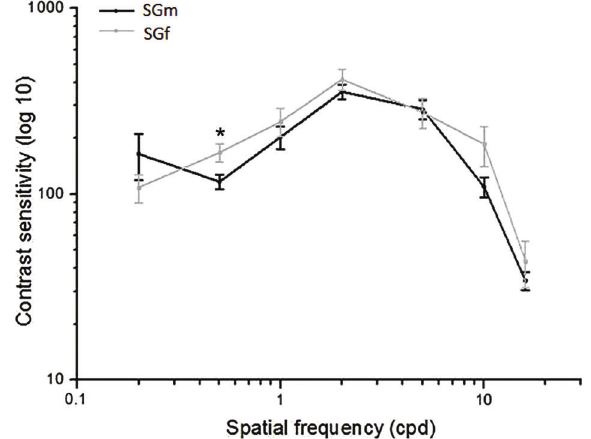
Figure 3. Male study group (SGm) and female study group (SGf) contrast sensitivity curve. Data are reported as means and vertical lines show the standard error of the mean for each spatial frequency (0.2, 0.5, 1.0, 2.0, 5.0, 10.0, and 16.0 cpd). *P o 0.05 (Mann-Whitney